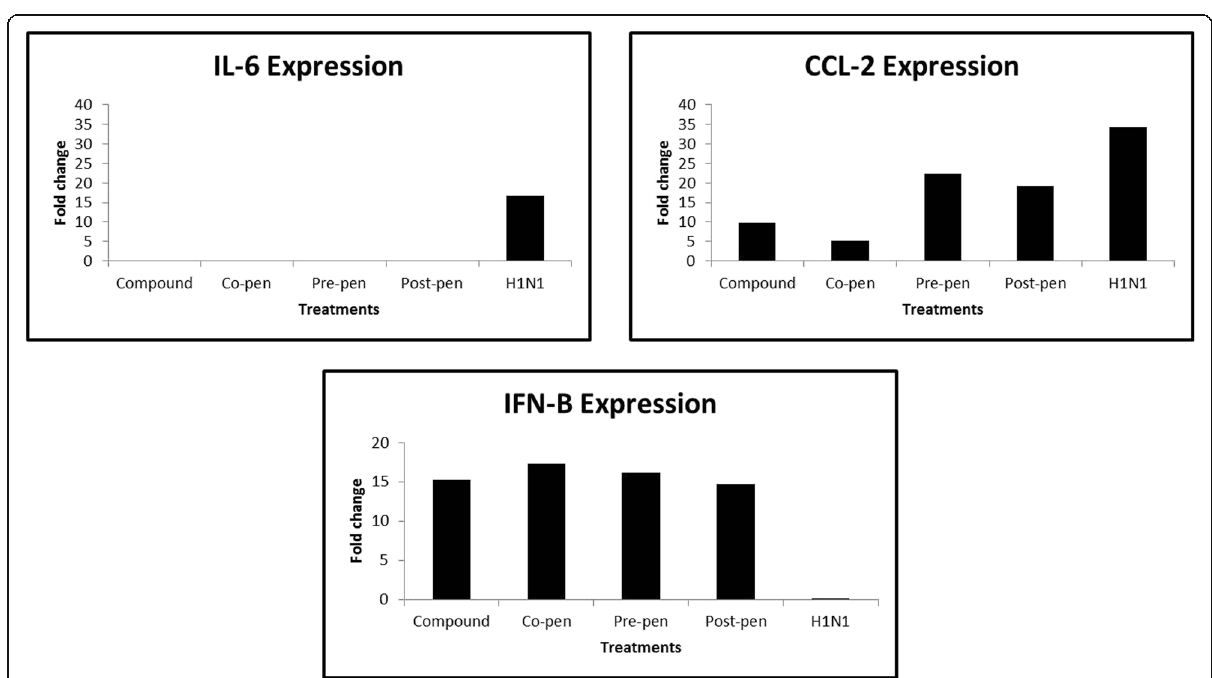
Fig. 1 Relative expression analysis ( ΔΔ Cq) of the cytokines compared to the positive control